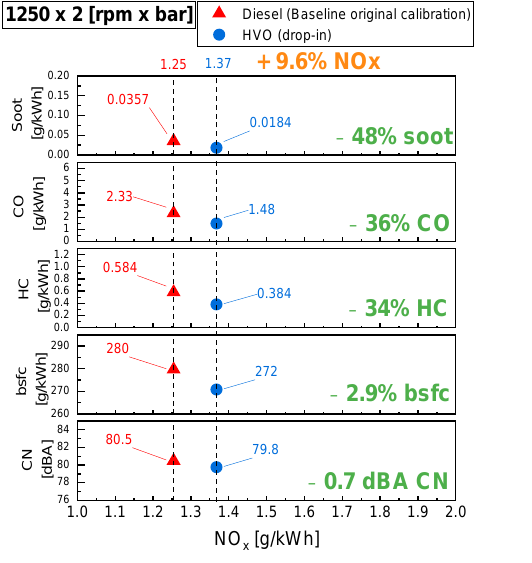
1.0 1.1 1.2 1.3 1.4 1.5 1.6 1.7 1.8 1.9 2.0